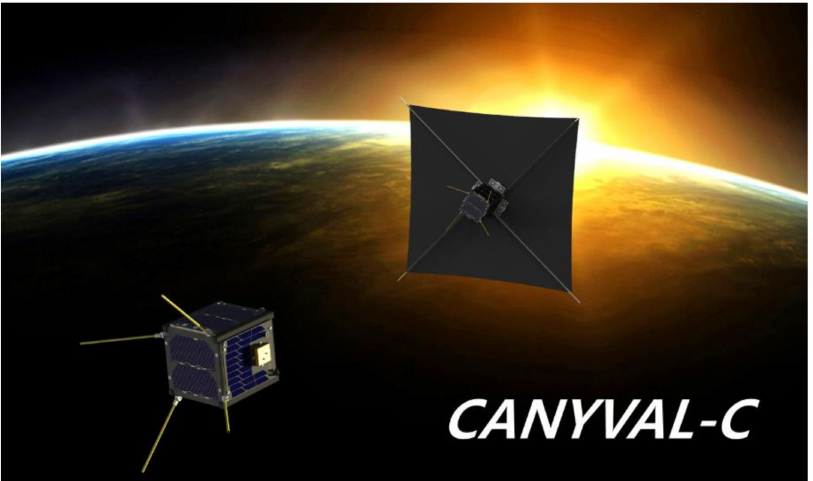
Figure 1. Concept of CANYAL-C mission [4]. The CubeSat on the left is Timon (1U CubeSat) and that on the right, with a deployed occulter, is Pumbaa (2U